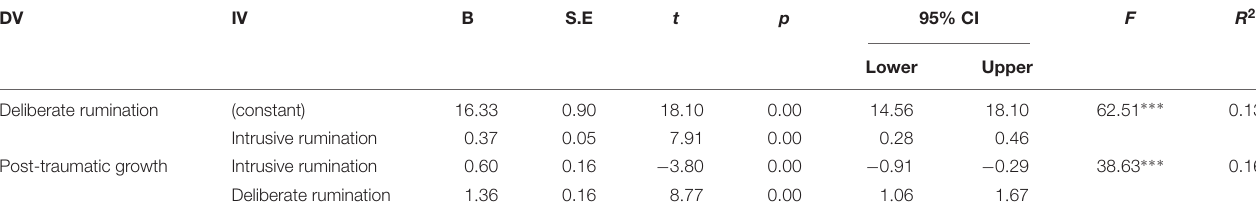
TABLE 3 | Mediating effects of deliberate rumination in relationship between intrusive rumination and post-traumatic growth). DV IV B S.E